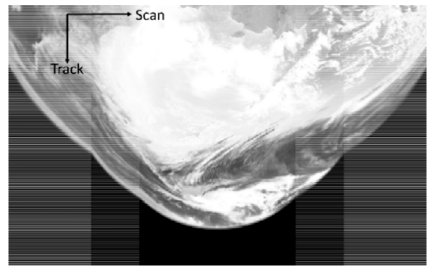
Figure 5. An image of NOAA-20 M15 EV counts during the beginning of pitch maneuverer (January 31, 2018, 13:42:23–13:48:04 UTC). The bright feature that occupies most of the image is the Earth. The dark portion of the image in the bottom shows the deep space data for on-orbit RVS characterization. The striping at the beginning and the end of scan are fill values due to bowtie deletion. Table 2. NOAA-20 and S-NPP pitch maneuver data used for on-orbit Response Versus Scan (RVS) characterization.